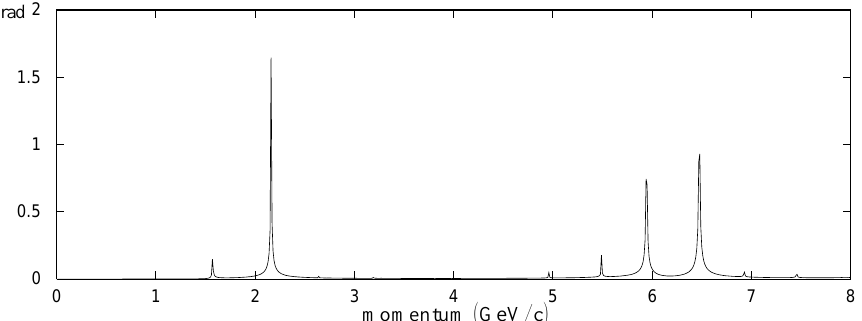
FIG. 4. SPRINT opening angles for a beam with normalized vertical emittance of 32 p mm mrad in DESY III.